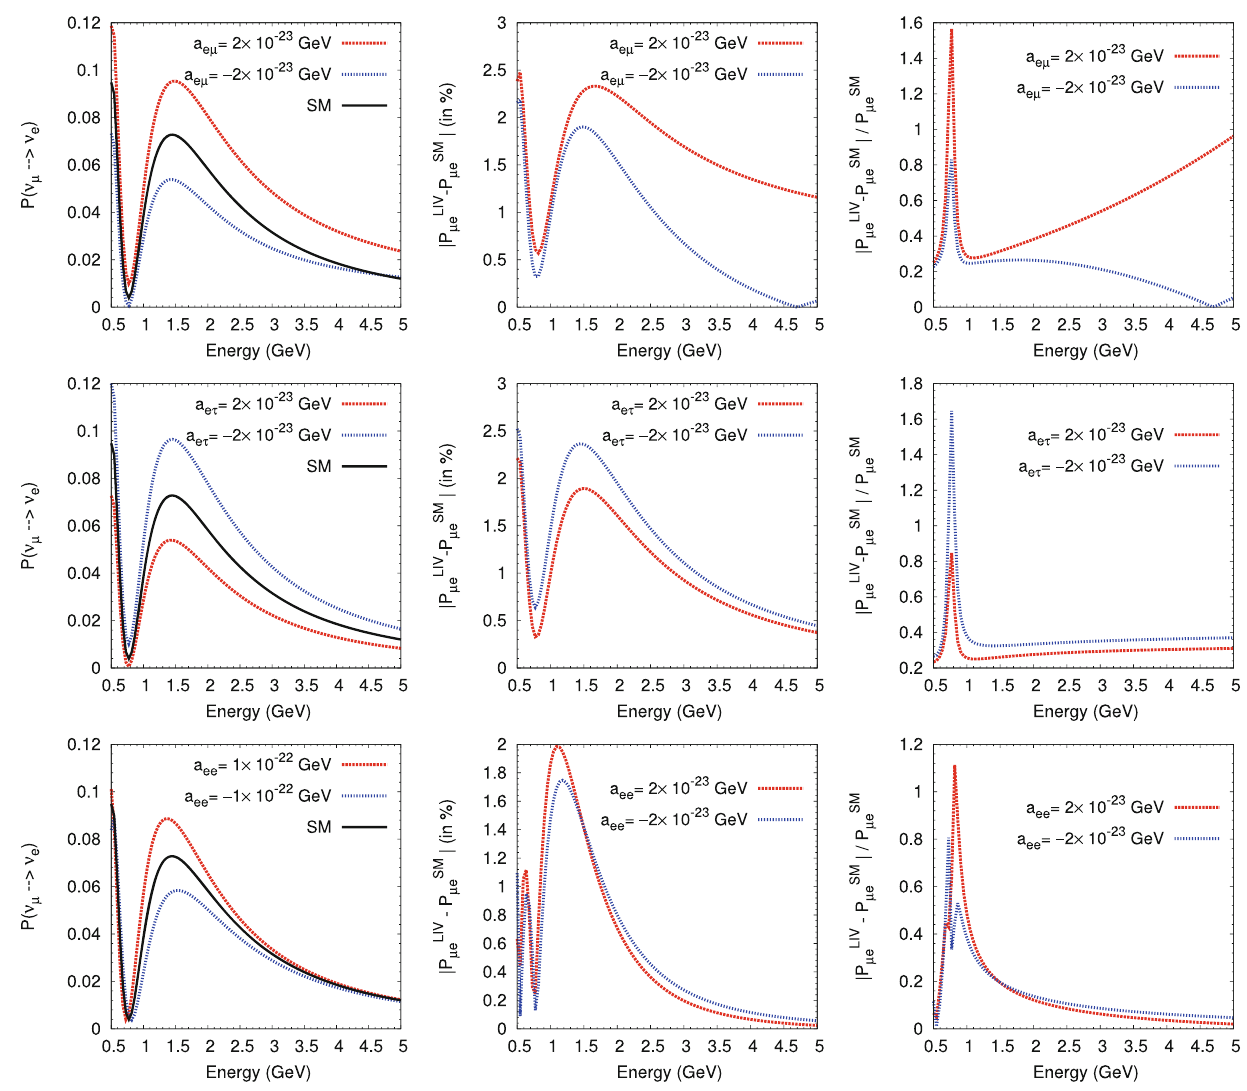
Fig. 1 The numerical oscillation probabilities for ν e appearance chan- nel as a function of neutrino energy for NO ν A experiment, in presence of Lorentz violating parameters a e μ , a e τ and a ee in the left panel. The